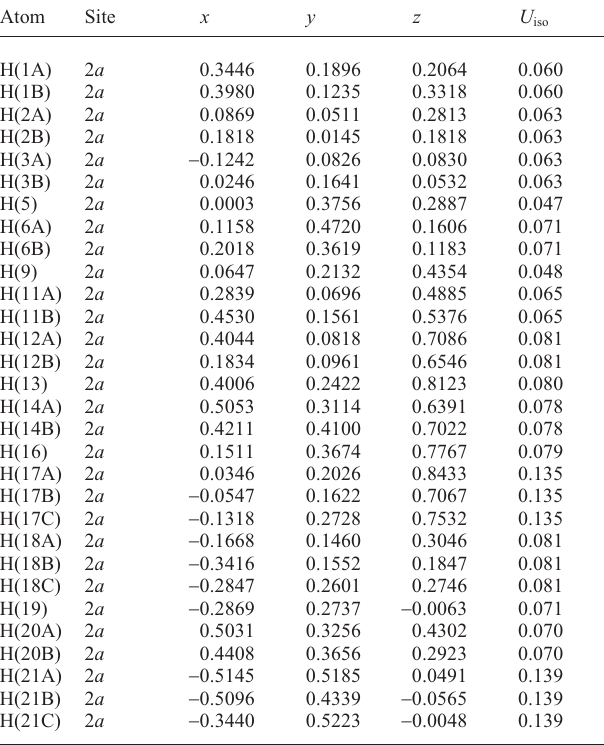
The title compound crystallizes with one molecule in the asym- metric unit of the acentric space group P2 1 (figure). Geometric parameters of the title compound are in the usual ranges. The compound contain one ketone, one lactone, one acetal, and two methyl-groups. The C(15)–O(4) distance is 1.210(3) Å. The lactone was confirmed by the distance of 1.205(3) Å, 1.341(3) Å, C(7)–O(3) and C(7)–O(2), respectively. The C(21)-O(5) dis- tance is 1.420(3) Å. The compound contains two five-membered ring and three six-membered ring. The intermolecular connection was achieved through non-classical hydrogen bonding with a